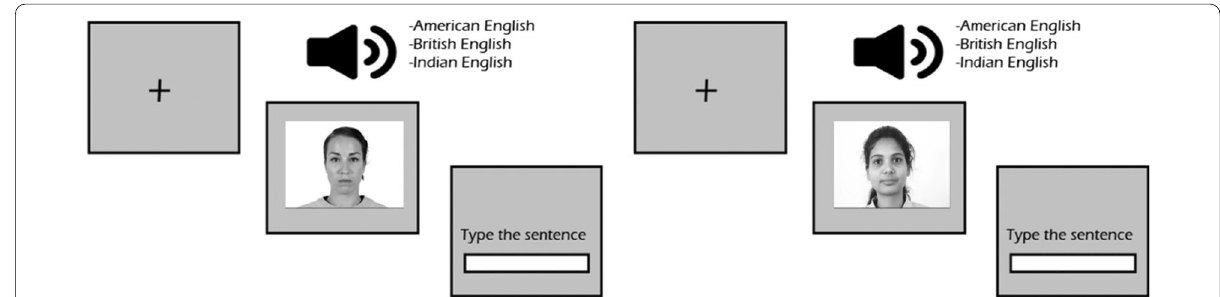
Fig. 2 The design of the intelligibility task (both pictures are allowed to be used for publication